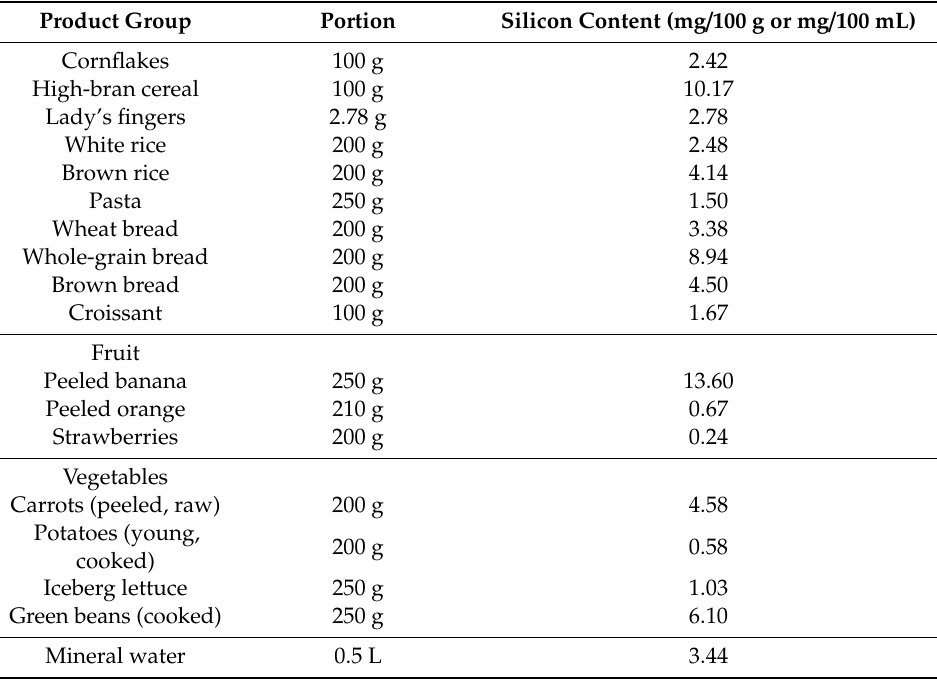
Table 2. Meals, portion sizes, and silicon content